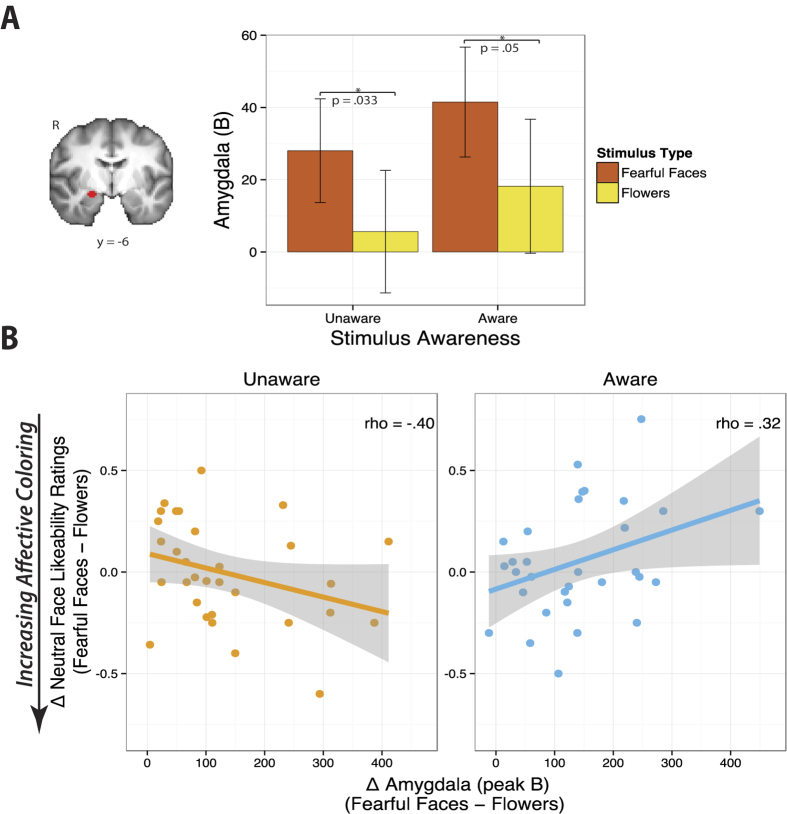
(A) Fearful faces increased right central amygdala BOLD response independently of conscious awareness. Using an anatomical ROI approach focused on the central amygdala, we found that right amygdala activation was significantly modulated by valence [fearful faces > flowers] in the unaware, p = 0.033, as well as in the aware condition, p = 0.05, with no valence by awareness interaction, p > 0.8. The right amygdala mask is displayed on the average normalized T1 images across all subjects. Error bars represent the within-subjects 95% confidence intervals per condition72. (B) Conscious awareness significantly altered the behavioral fate of amygdala responses to fearful faces (relative to flowers). Greater amygdala responses to fearful faces (relative to flowers) were associated with reduced liking of subsequently presented neutral faces, but only when participants were unaware of the emotional stimuli, pUnaware = 0.026 vs. pAware = 0.076; pslope difference < 0.01. Here (and on subsequent scatterplots) each data point denotes a subject.